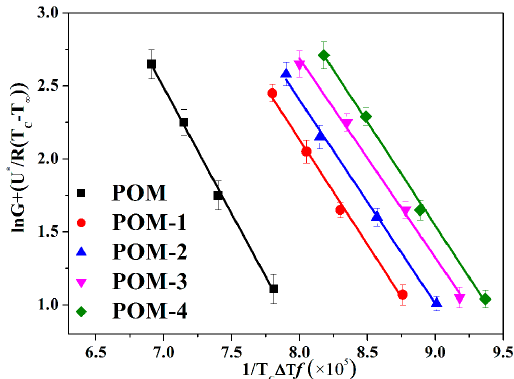
Figure 9. Lauritzen ‐ Hoffman model plots of POM/Ag nanocomposites. Figure 9. Lauritzen-Ho ff man model plots of POM / Ag